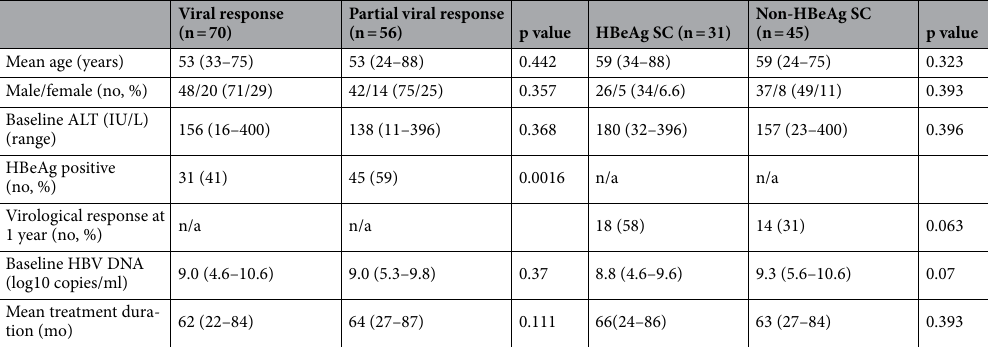
Table 2. Clinical characteristics of treatment outcome of CHB patients after ETV monotherapy. SC